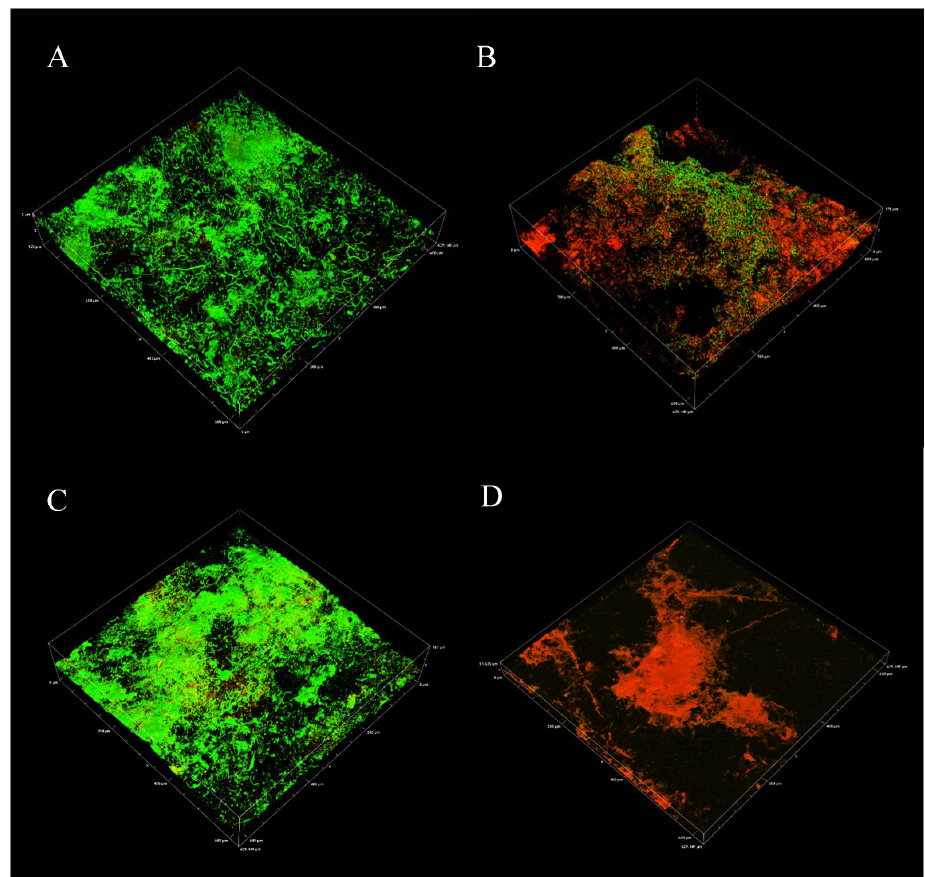
Figure 2. Confocal laser scanning micrographs showing live and dead cell in control biofilms compared to treatments, where: ( A , C ) = control biofilm, ( B ) = CTA-4OHcinn treated biofilm, and ( D ) = dual CTA-4OHcinn and DNase treated biofilm. Control micrographs ( A , C ) were captured from separate experiments before their respective treatments. Live cells are indicated by green, and dead or damaged cells are indicated by red.